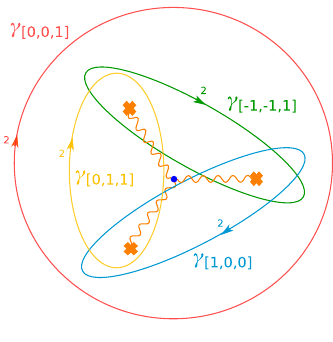
Figure 3 . Charges of BPS hypermultiplets at m = − 1 / 10 , Λ = 1 and u = 0 as loops on the z plane. We use orange crosses to denote the turning points of the SW differential. They are branch points of the covering Σ → C . The orange wavy lines represent the branch cuts. The blue dot denotes the singularity at z = 0 . There is another singularity at z = ∞ . In the strong coupling region, we have 3 BPS states corresponding to the blue, green and yellow cycles. The pure flavor charge is plotted as a large red